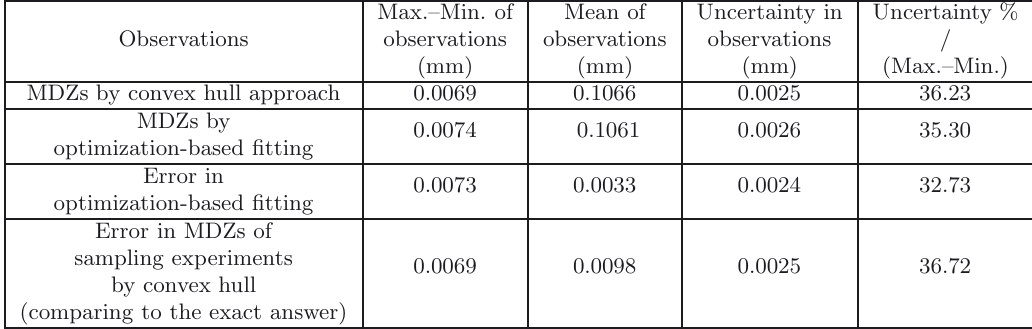
Table 3. Uncertainties in evaluation of MDZ of sample